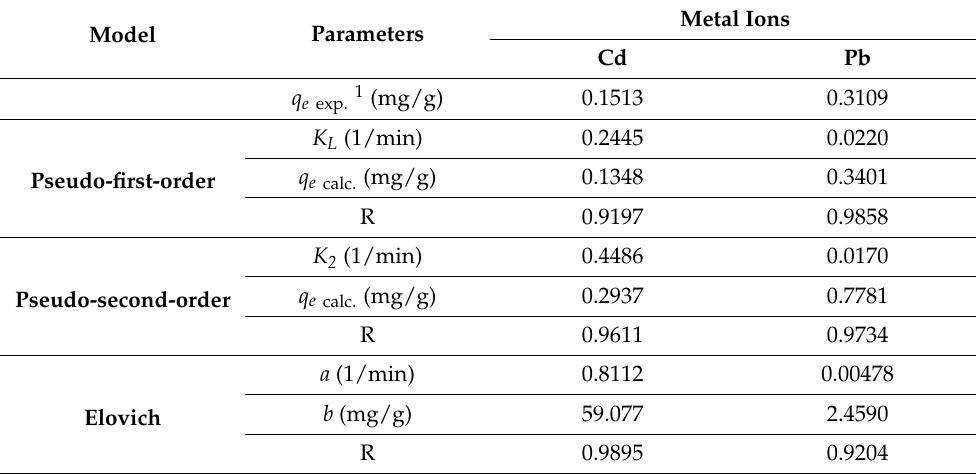
Table 2. Parameters of kinetic models for cadmium (Cd) and lead (Pb) adsorption onto FeNP/NFC. Model